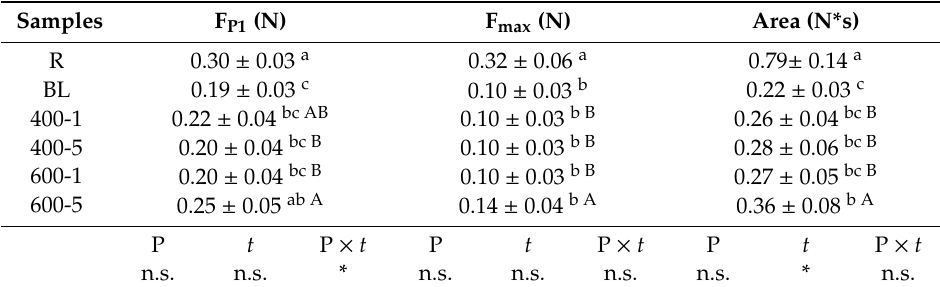
Table 2. Texture parameters † for raw and treated